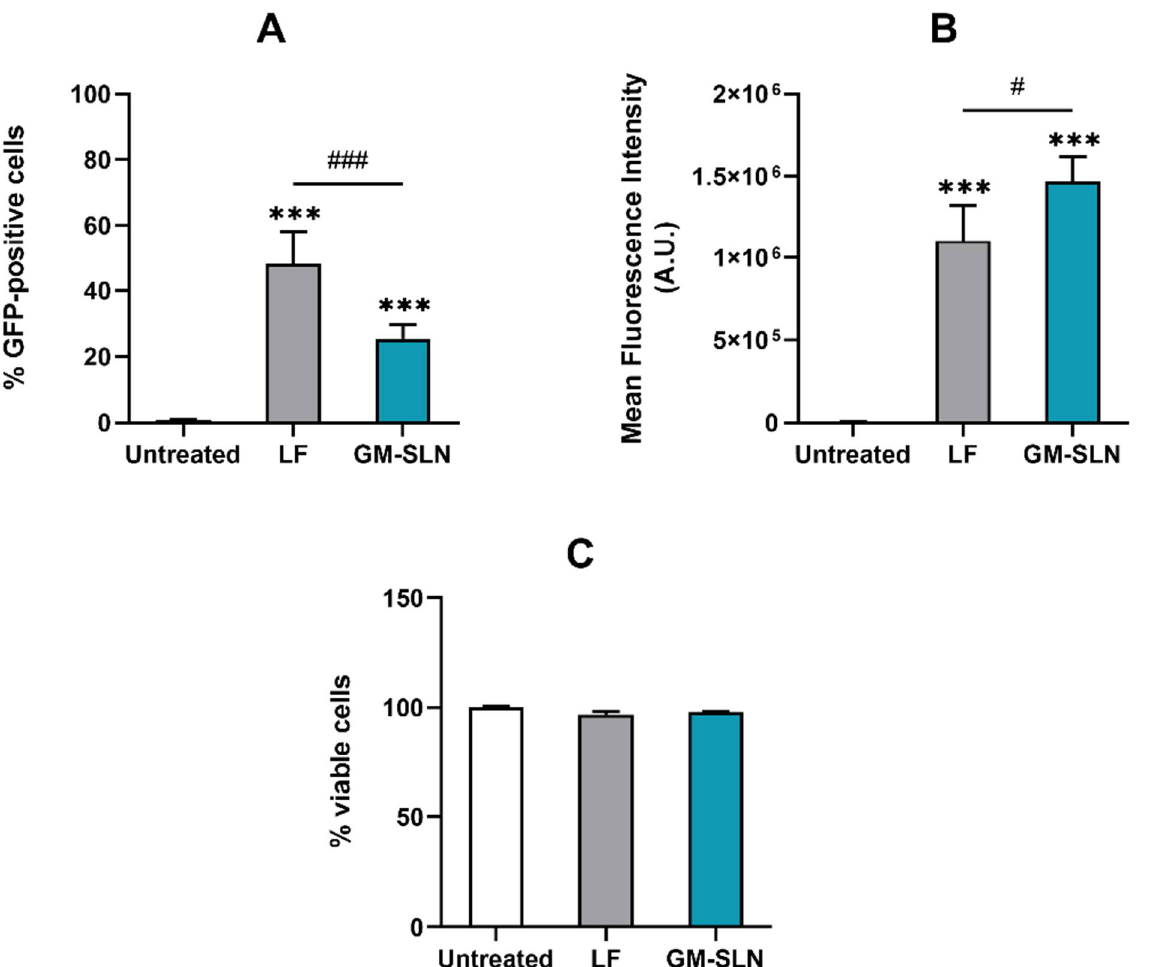
Figure 8. Transfection efficacy and cell viability analysis by flow cytometry in Hep G2 cells 3 days post-transfection. ( A ) Percentage of GFP-positive cells. The percentage of GFP-positive cells corre- sponds to fluorescent GFP cells over total cells. ( B ) Mean fluorescence intensity. Mean intensity of fluorescence indicates the average intensity of fluorescence per labeled cell. ( C ) Percentage of viable cells. Results are shown as the mean ± standard deviation ( n = 3). Statistical significance: *** p < 0.001 in comparison to untreated cells. # p < 0.05, ### p < 0.001. A.U.: arbitrary unit. GFP: green fluorescent